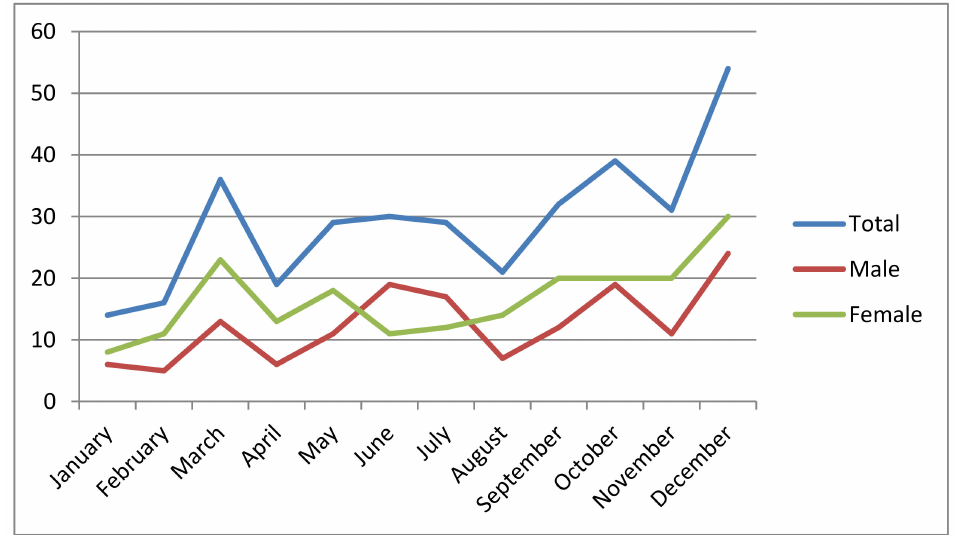
Figure 3. Positive results of the hs-cTn I test, separately presented for males and females. A distribution by